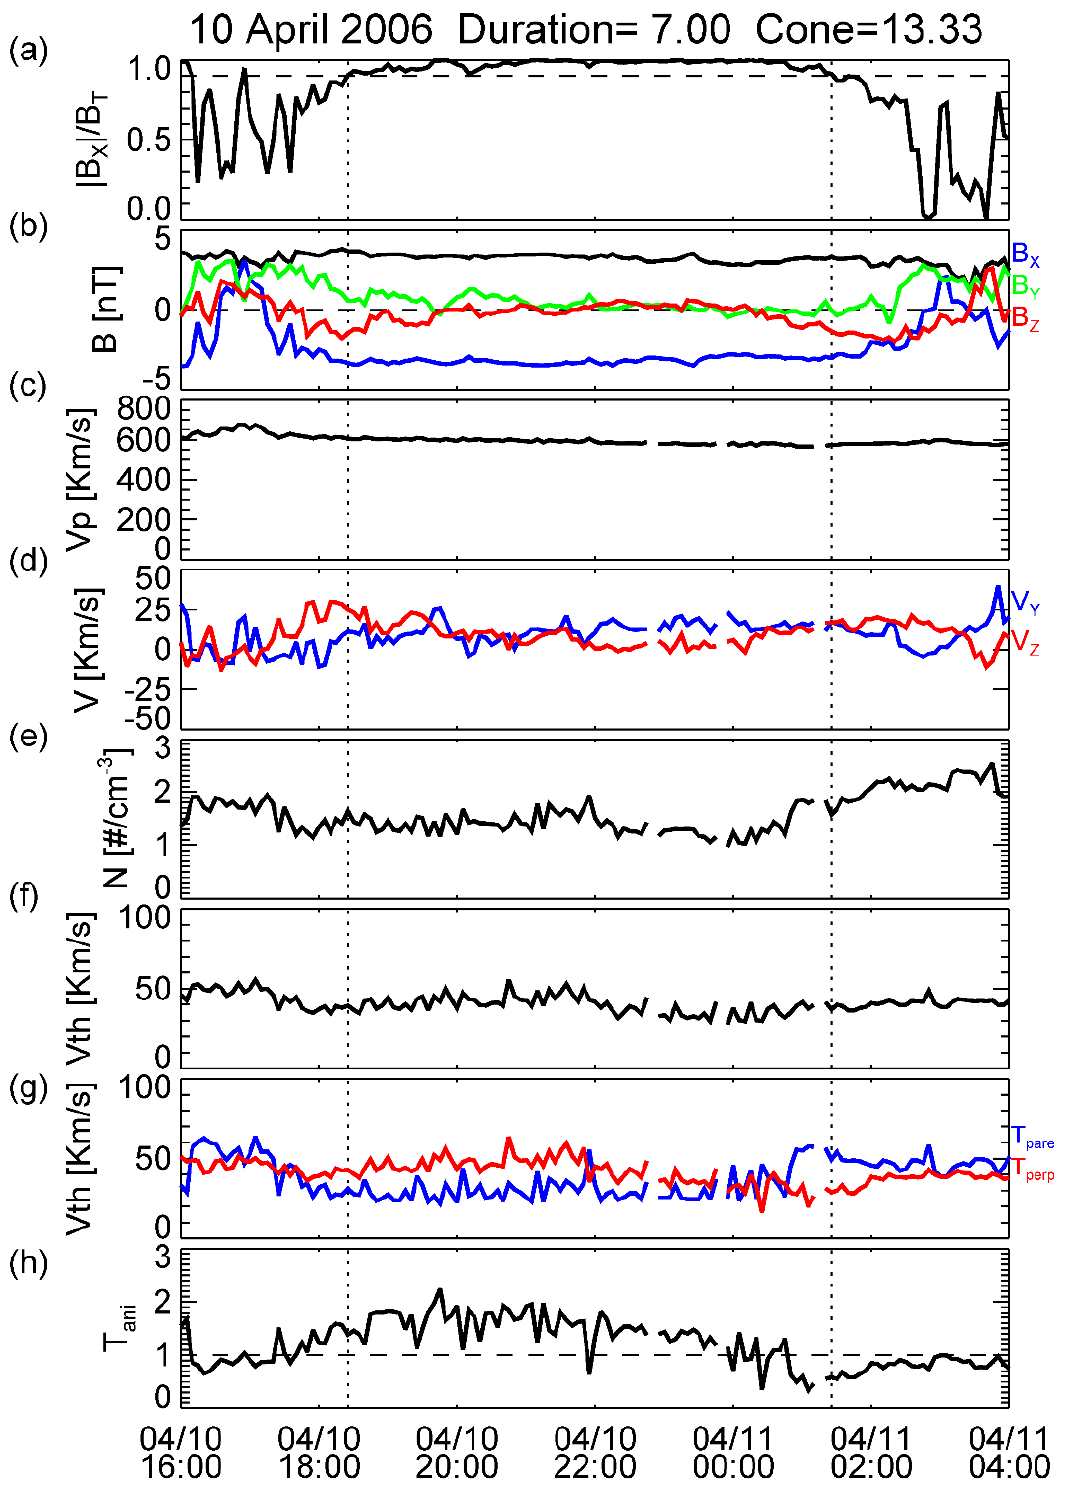
| |𝐵 (cid:3051) 𝐵(cid:3415) , ( b ) , ( b ) magnitude B